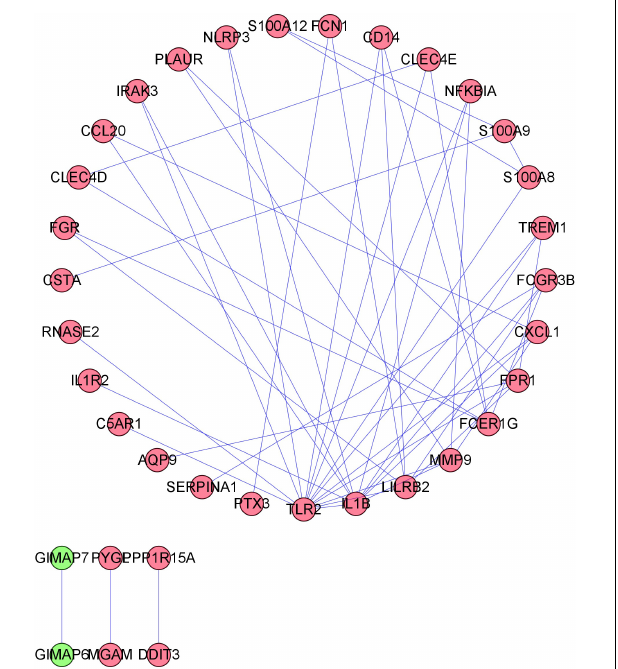
FIGURE 6 | Protein–protein interaction (PPI) network construction. Circles and lines represent genes and the interaction of proteins between genes, respectively. The red represents the upregulated genes. The green represents the downregulated genes.